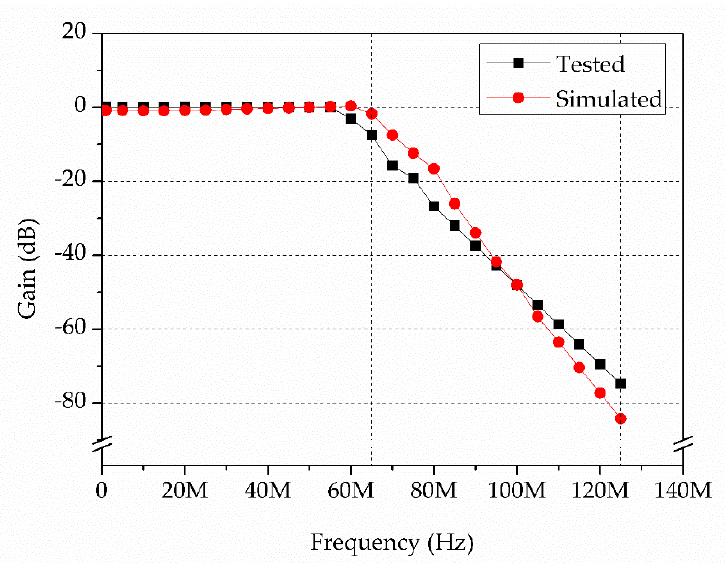
Figure 4. Frequency–amplitude response of the LPF.